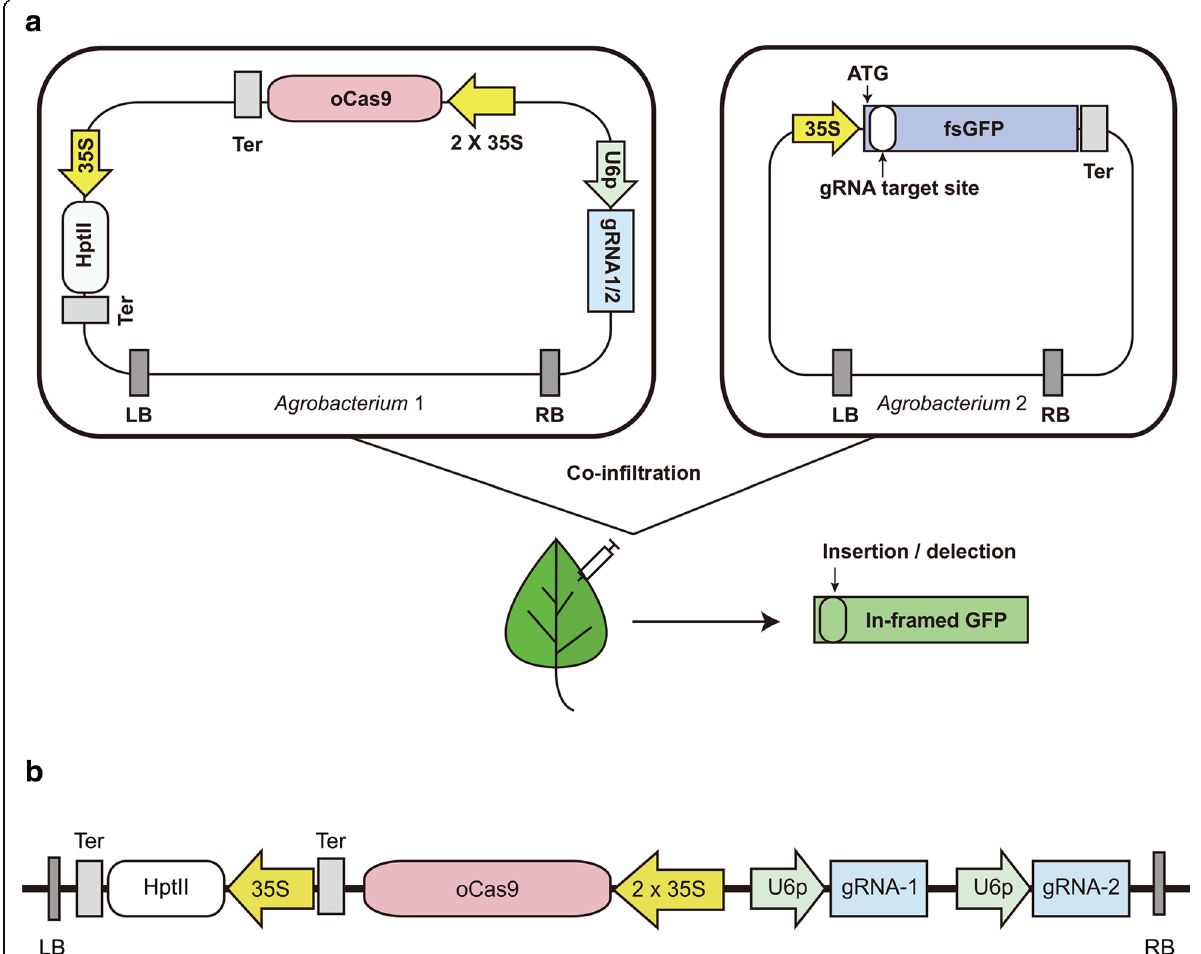
Fig. 2 Schematic representation of the experimental design of fsGFP assay and vector for generation of transgenic plants. a fsGFP assay to determine gRNA activity. b Schematic diagram of T-DNA region in a vector for generation of transgenic N. benthamiana plants. Arabidopsis U6 promoter is used to direct the expression of gRNA. oCas9, Arabidopsis codon-optimized Cas9; LB, left border; RB, right border; Ter, terminator; HptII, hygromycin phosphotransferase